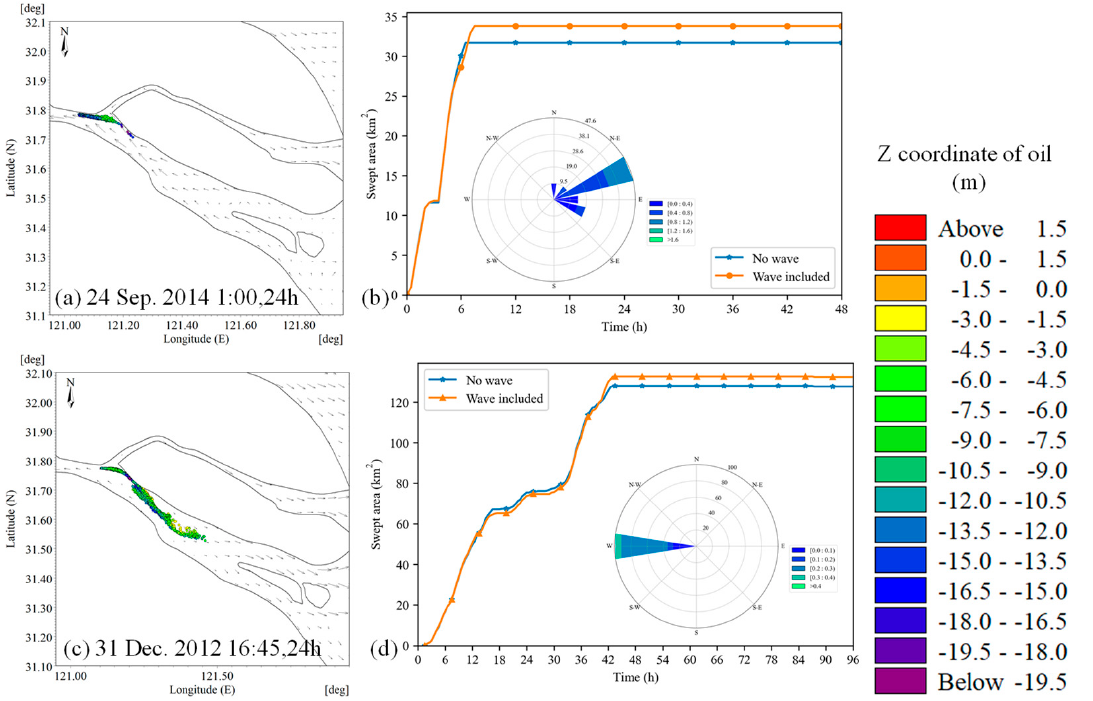
Figure 12. ( a , c ) oil particle tracks during typhoon and real accident, respectively. Furthermore, ( b , d ) the swept areas (km 2 ) of simulation, including wave or without wave, corresponding to ( a , b ). The inserted plots are the wave-rose charts after oil spills in 24 h, and the SWH and mean wave direction of ( b , d ) are 0.35 m, 70.63°, and 0.11 m, 274.67°, respectively. The color of circles indicates the z coor- dinate of oil particles.